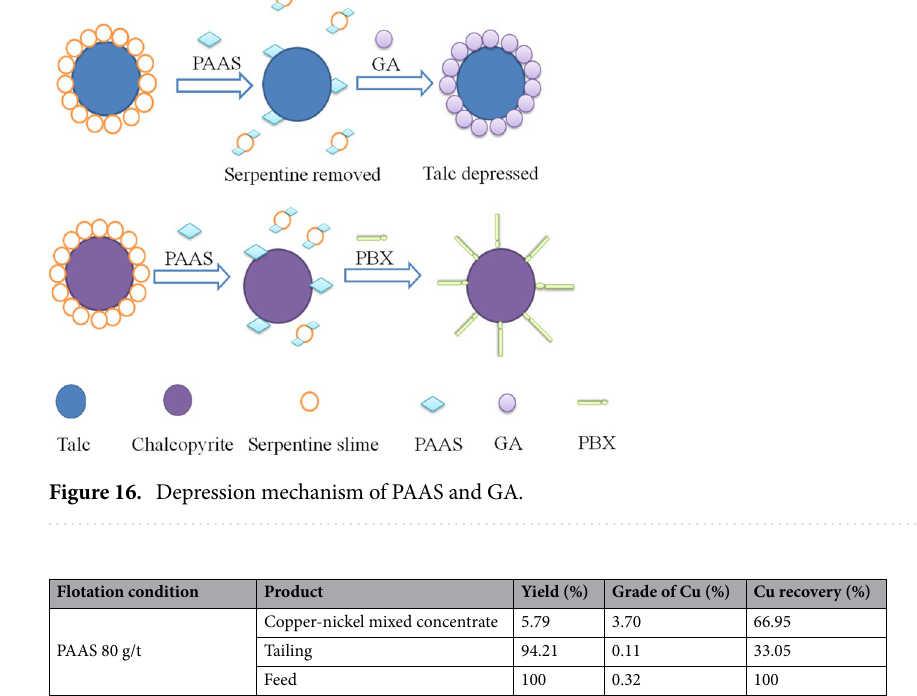
Flotation condition